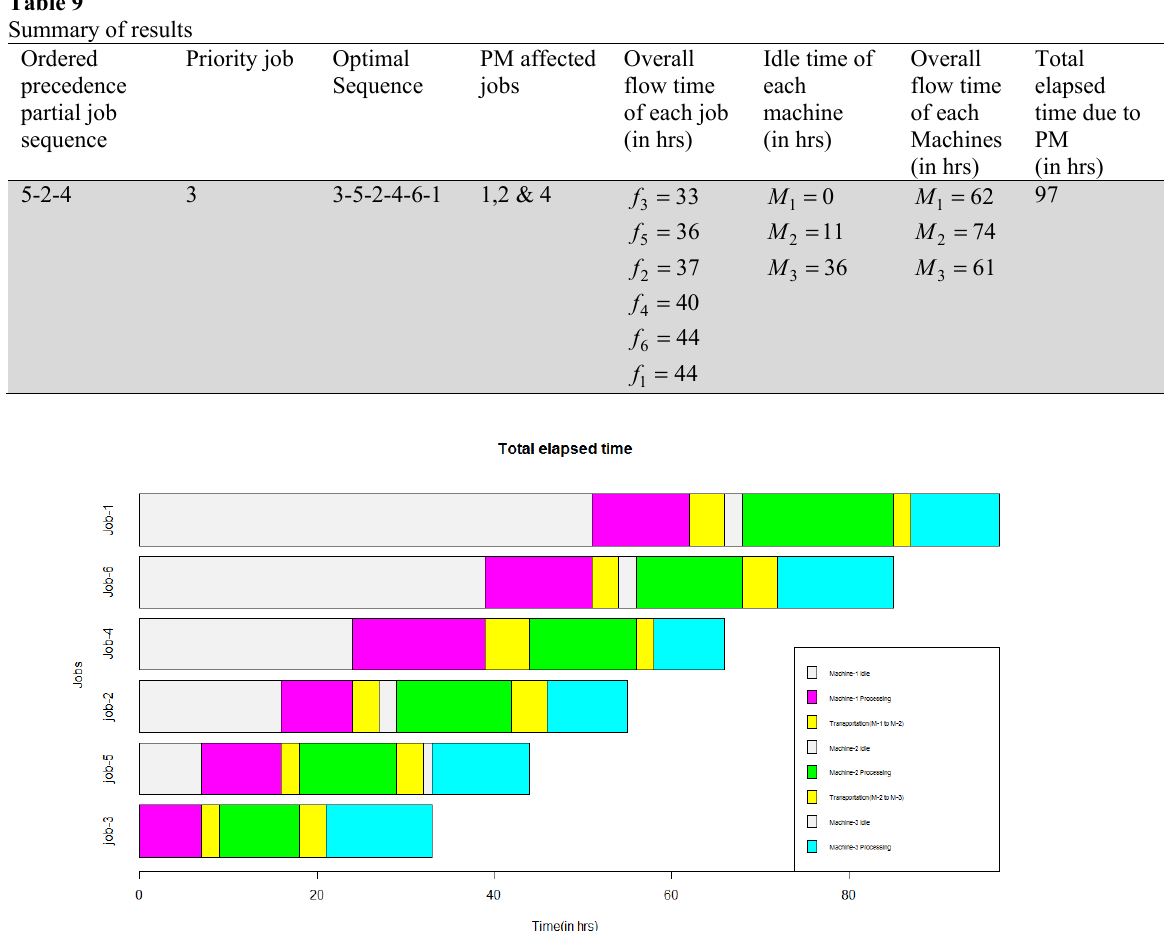
Summary of results Ordered